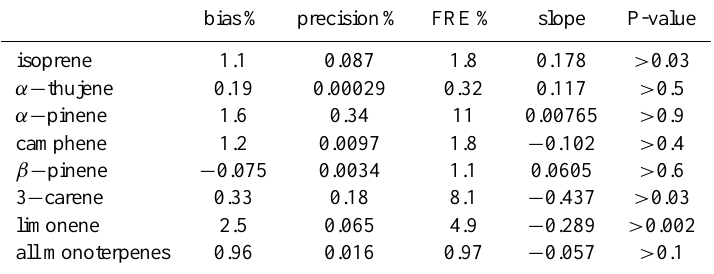
Table 7. Relative bias and the precision of the bias estimate. Positive bias values indicate a loss compared to the sample using ozone removal and negative values a gain. The fraction of random error (FRE) contributing to the bias estimate how much of the difference between the parallel samples may be explained by random error. The slope and P-values refer to the linear trend lines in Fig. 6. bias% precision% FRE%